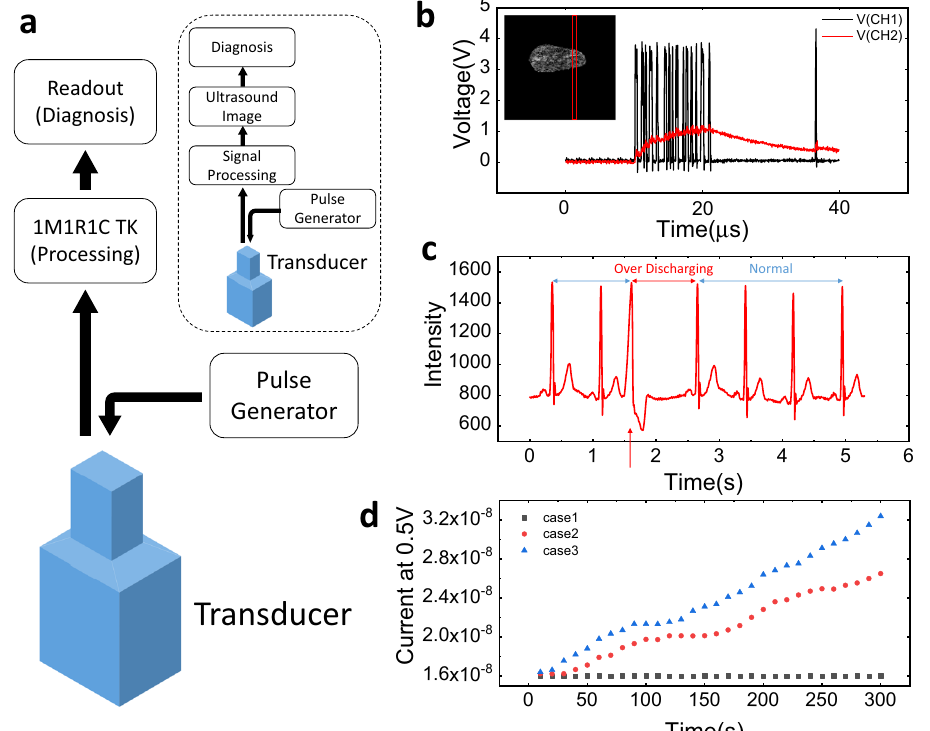
Fig. 4 The automatic medical diagnosis system using the 1M1R1C temporal kernel and the experiment results in the two sections. a A system for diagnosing the malignancy of breast lesions, which is much simpler than in the existing method (inset in a ). In this system, ultrasonic signals are applied directly to the kernel machine, so the imaging step is omitted. b V – t graph for one echo line of a benign sample (inset in Fig. 4b). c A part of the electrocardiogram of a patient with arrhythmia. Long intervals caused by abnormal beats discharged the capacitor, and the conductance of the memristor increased in the next pulse. d Five-minute temporal kernel monitoring based on the ECG of one normal patient (case 1) and two arrhythmic patients (cases 2 and 3). When arrhythmia occurred, the conductance of the memristor increased. Case 3, which had the most severe arrhythmia symptoms, showed the highest